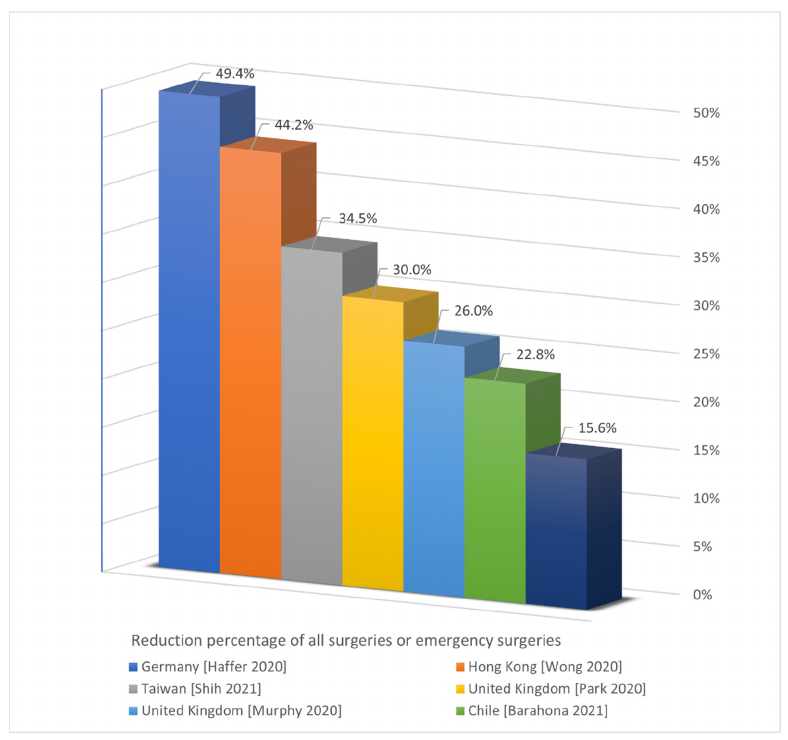
J. Clin. Med. 2022 , 11 , x FOR PEER REVIEW Figure 2. Reduction percentage of all surgeries or emergency surgeries. Figure 2. Reduction percentage of all surgeries or emergency surgeries [15,20,22,31,33,50,56].